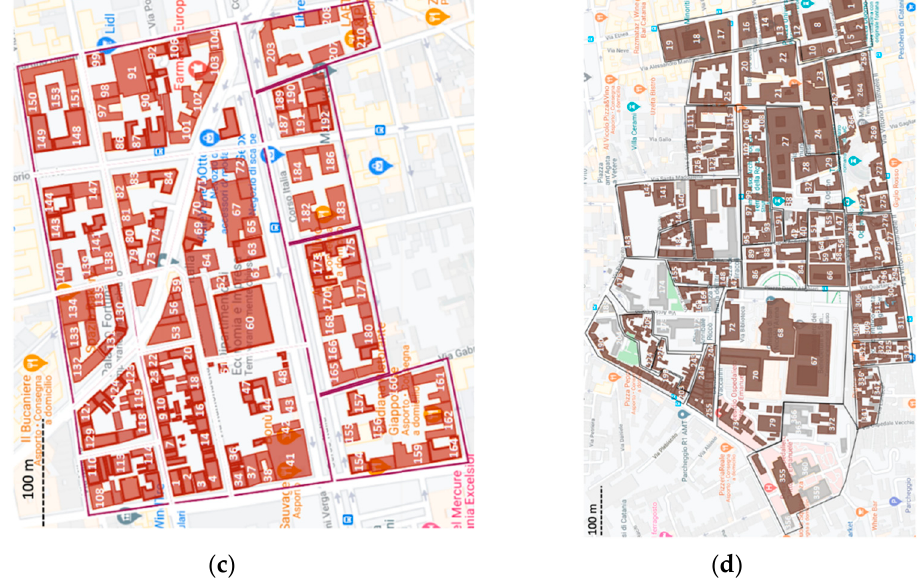
Figure 19. Location of buildings in the investigated areas: ( a ) west area; ( b ) northeast area; ( c ) north Old Town; ( d ) south Old Town.